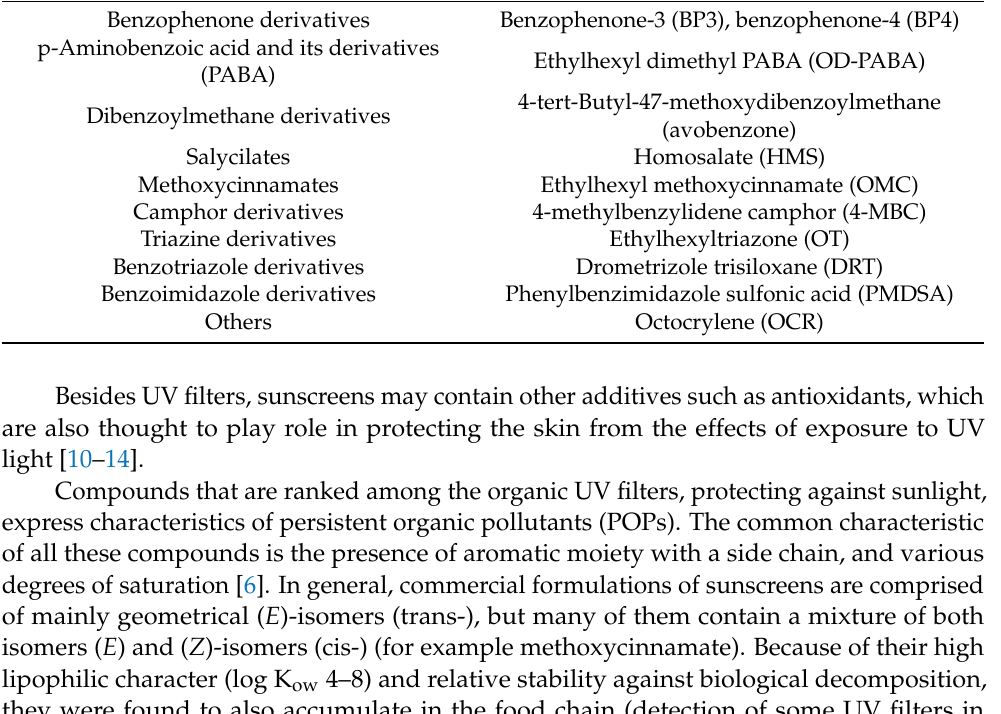
Table 1. Classification of organic UV filters according to chemical structure. Group Typical Representatives Benzophenone